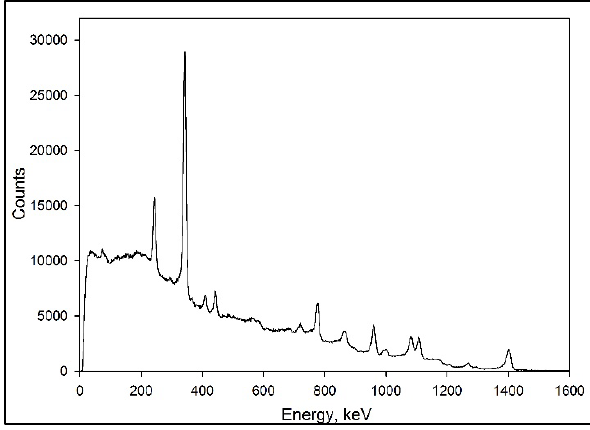
Fig.4. An example of a instrumental spectrum of radiation of control and safety